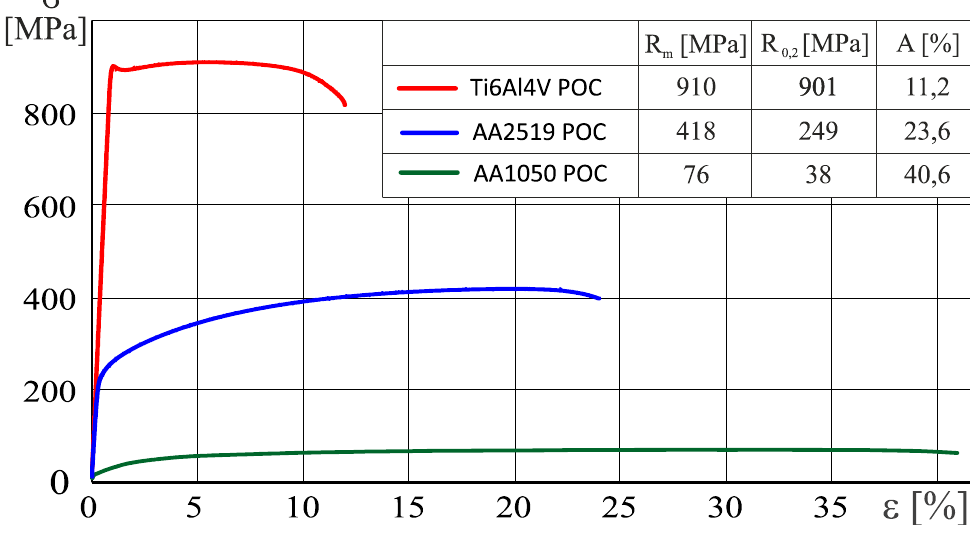
Figure 6. Monotonic tensile test chart for dog-boned samples made of the base material.